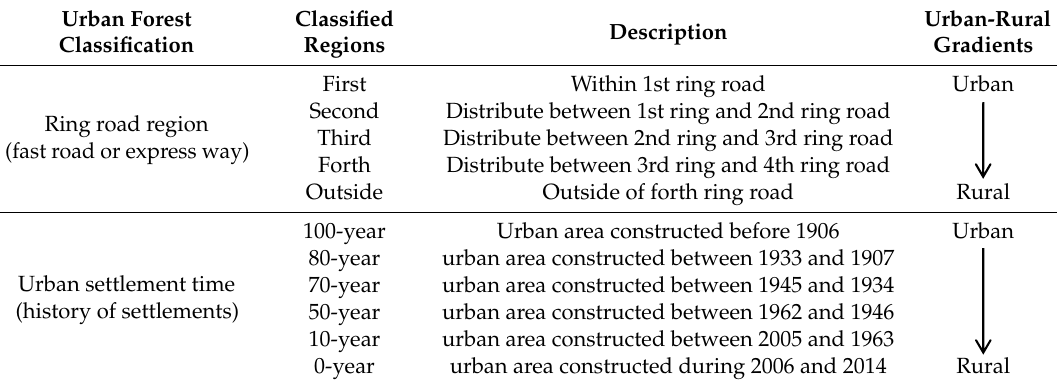
0-year urban area constructed during 2006 and 2014 Rural Note: the black arrows represent the urbanization degree from high to